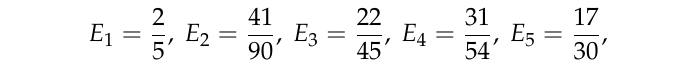
Table 3. Context-independent language evaluation matrix D 1 ( ll ij ) . C 1 Higher than Higher than very good very good Between poor A 3 Medium and medium Between Higher than A 4 medium and very good good Between poor Lower than A 5 very poor and medium Table 4. Hesitant fuzzy linguistic term set decision matrix (cid:101) X 3 ( H 3 C 1 C 2 C 3 C 4 C 5 A